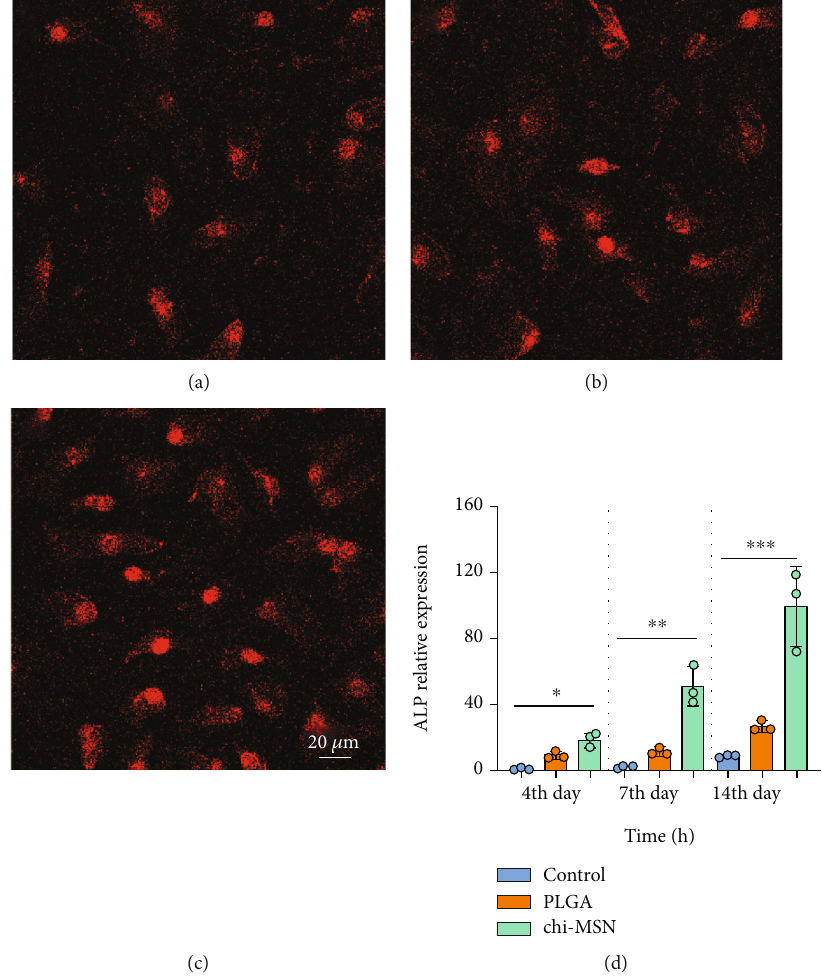
Figure 6: Mineralization of BMSCs. (a – c) ALP fl uorescent staining on the 14th day in control, PLGA, and Chi-MSN groups. (d) Quantitative evaluation of ALP expression in control, PLGA, and Chi-MSN groups. ∗ P < 0 : 05 , ∗∗ P < 0 : 01 , and ∗∗∗ P < 0 : 001